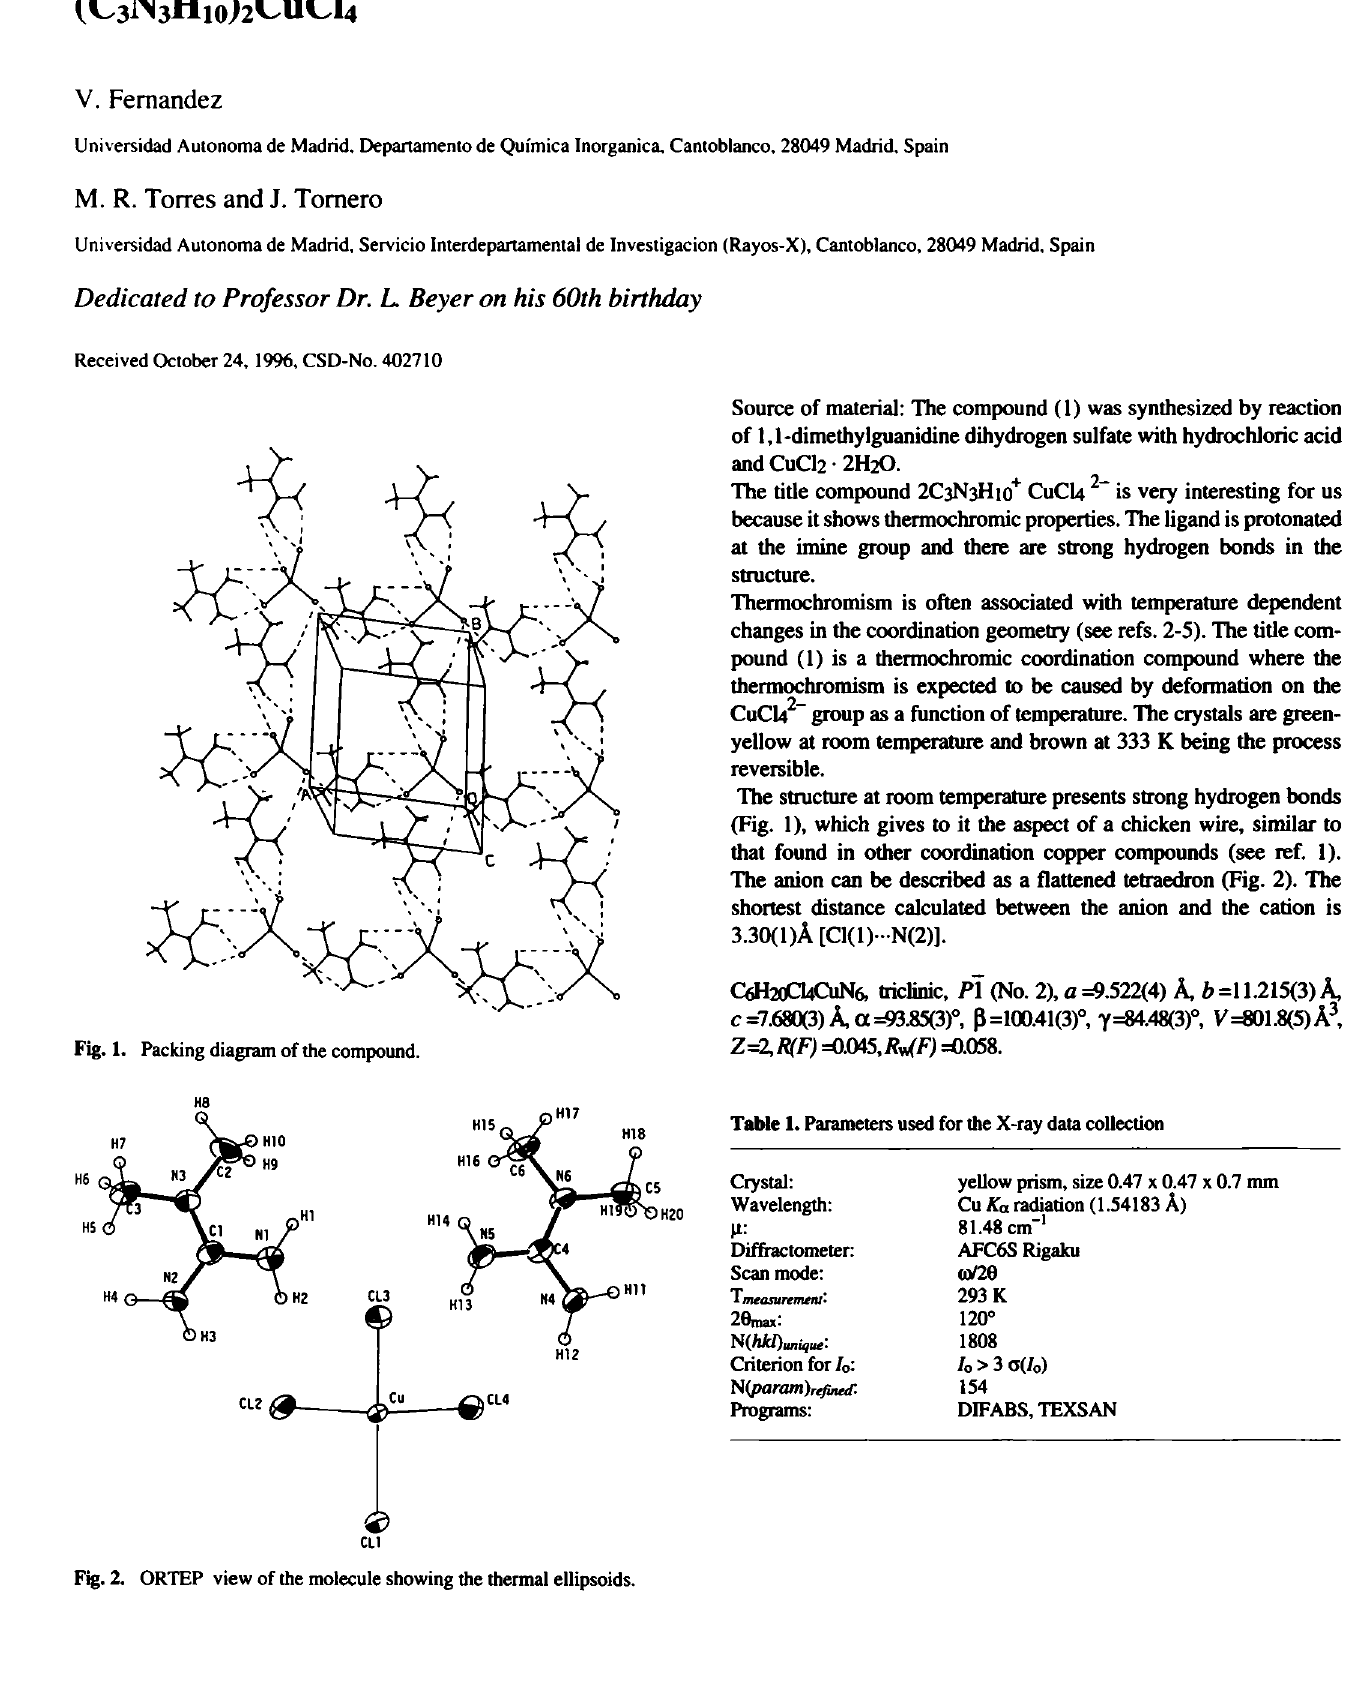
Table 1. Parameters used for the X-ray data collection